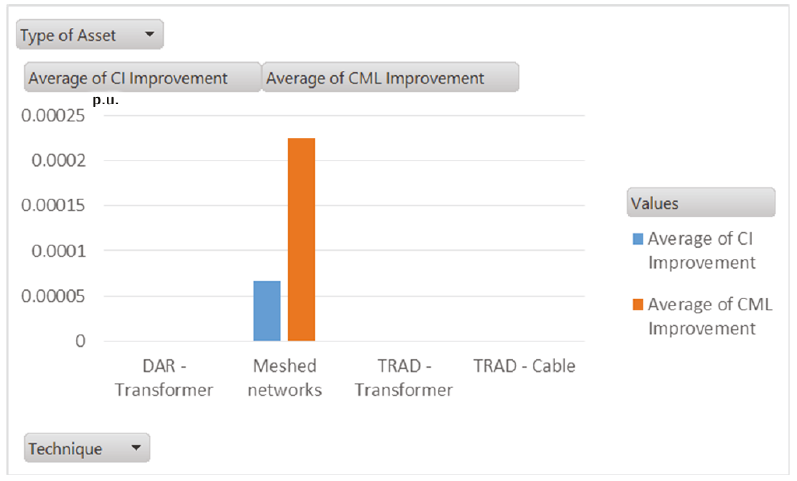
Figure 16: Average CML and CI improvement per technique; DECC2, 2015 –